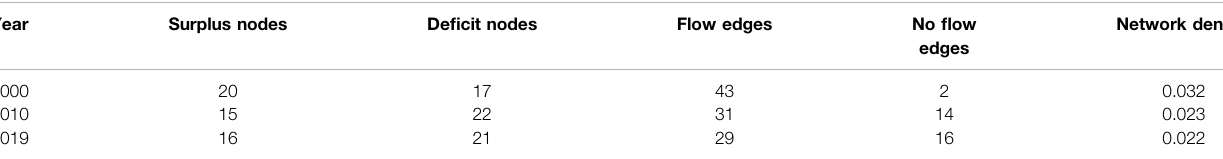
TABLE 5 | Overall characteristics of service fl ow